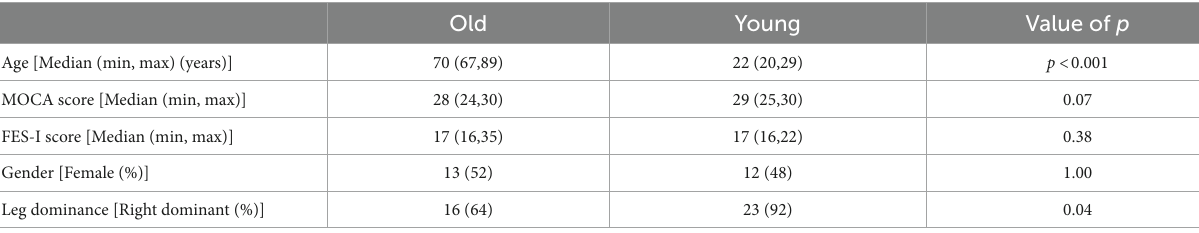
TABLE 1 Descriptive statistics of study